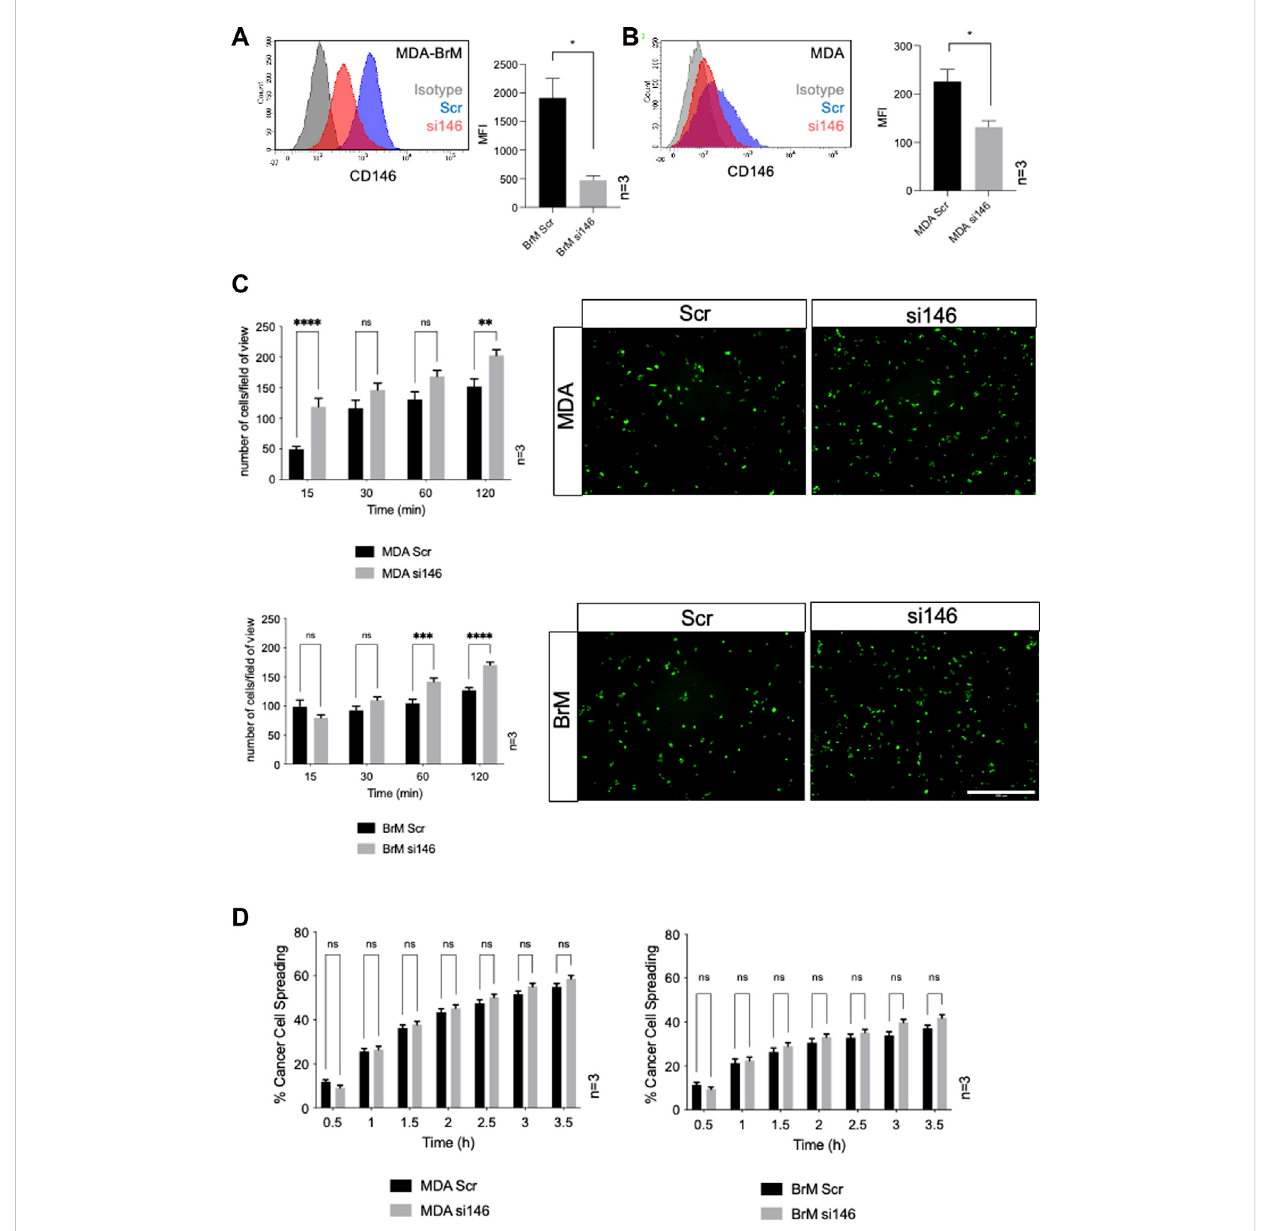
FIGURE 3 MCAM negatively regulates adhesion of breast cancer cells to endothelial cells (A) MDA-BrM cells were transiently transfected with siRNA targeting CD146 (si146) or a scrambled control siRNA (Scr), and CD146 expression was determined using fl ow cytometry 72 – 96 h post-transfection, compared to isotype control (grey histogram). For quanti fi cation, the mean fl uorescence intensity (MFI) of CD146 expression in the Scr-treated cells was compared to si146-treated cells. Bar charts show data derived from three independent experiments. Error bars indicate S.D. Analysis was performed using an unpaired T-test; * p < 0.05. (B) Inhibition of CD146 expression in MDA cells, details as in (A) . (C) Adhesion of siRNA transfected MDA (top panels) or MDA- BrM cells (lower panels) transfected with CD146 (si146) or scrambled (Scr) control siRNA to HUVEC monolayers for indicated time points. The